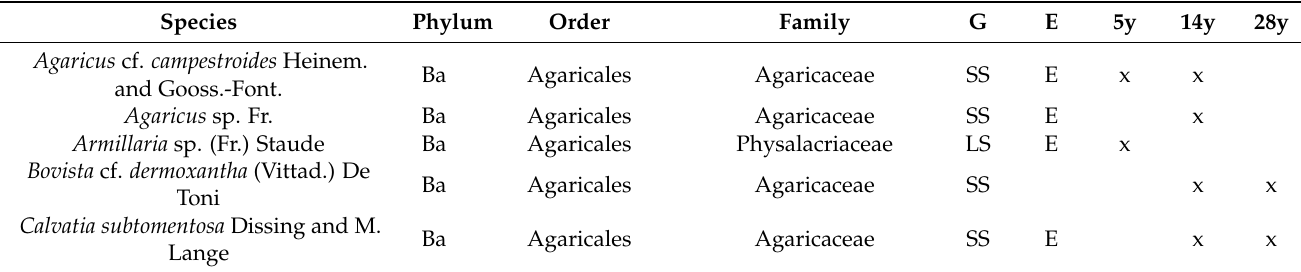
Table 2. List of fungal taxa collected from Pinus radiata stands in Menagesha Suba, central Showa, Oromia National Regional State, Ethiopia. Species Phylum Order Family G E 5y 14y 28y Agaricus cf. campestroides Heinem. Ba Agaricales and Gooss.-Font. Agaricus sp. Fr. Ba Agaricales x Armillaria sp. (Fr.) Staude Ba Agaricales x Bovista cf. dermoxantha (Vittad.) De Ba Agaricales Agaricaceae x x Toni Calvatia subtomentosa Dissing and M. Ba Lange